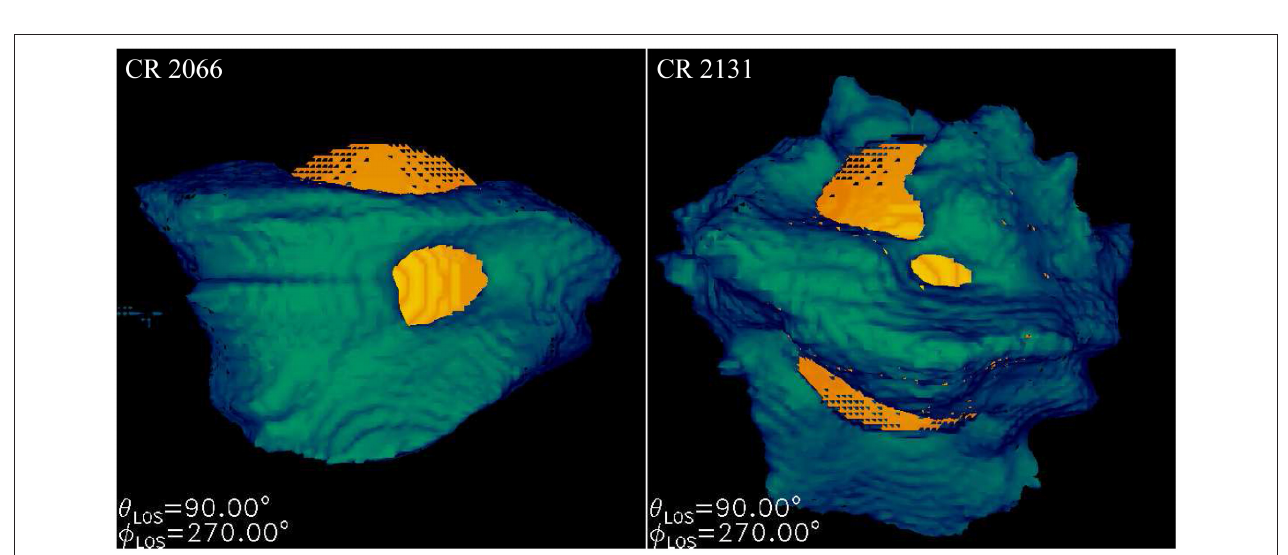
FIGURE 6 | Isosurface of coronal electron density value of 10 6 cm − 3 (in blue) for CR 2066 (left) and 2131 (right). The orange sphere is located at 1.5 R ⊙ just for scaling purpose. The movie demonstrating the isosurfaces for the whole longitudinal projection range is provided in online version of the paper.